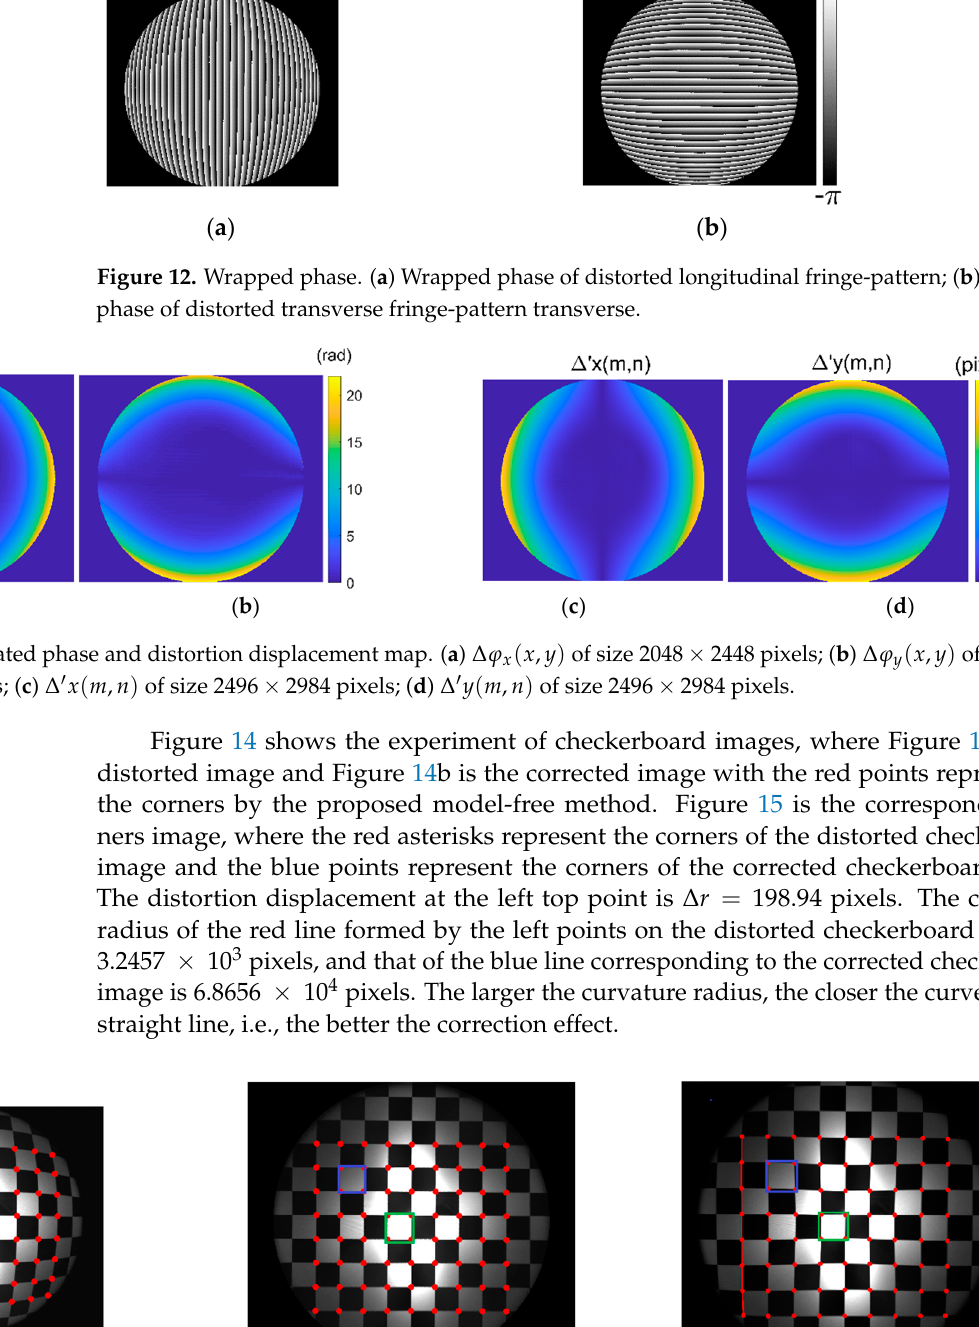
Figure 14. Experimental results of checkerboard images. ( a ) Distorted checkerboard image of size 2048 × 2448 pixels; ( b ) Corrected image of size 2496 × 2984 pixels with the red points representing the corners by the proposed model-free method. The pixel count of the square within the central green rectangular region is 49,033 pixels, and that of the square within the external blue rectangular region is 48,460 pixels. ( c ) Corrected image by plumb-line method. The curvature radius of the red line is 3.2821 × 10 4 pixels. The pixel count of the square within the central green rectangular region is 46988 pixels, and